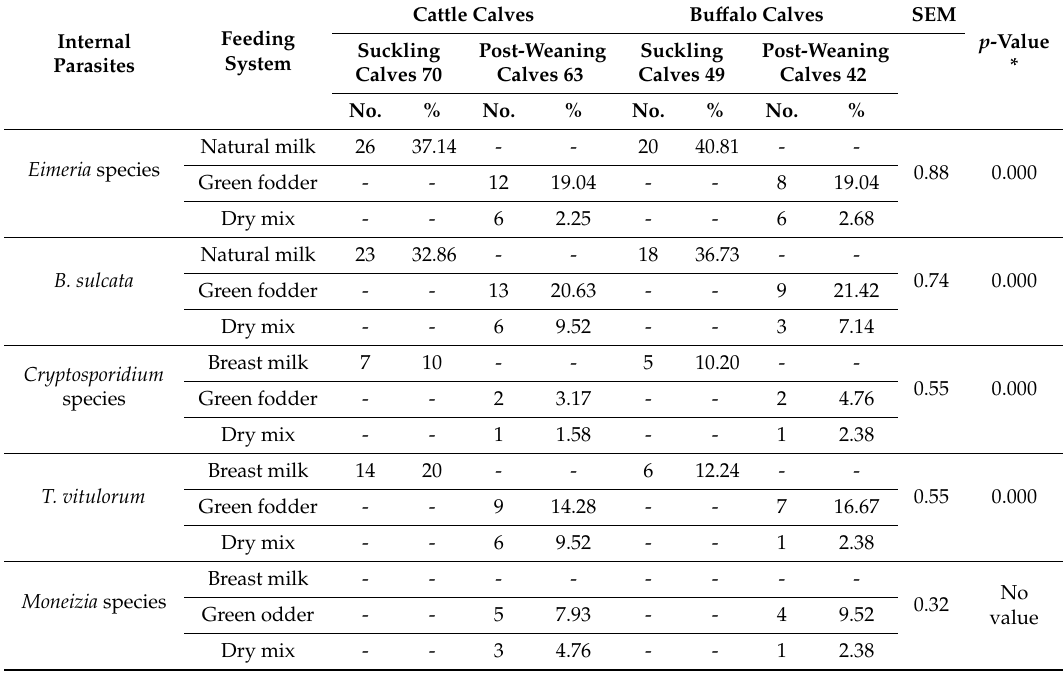
Table 5. Prevalence rate of parasitic diarrhea in relation to feeding